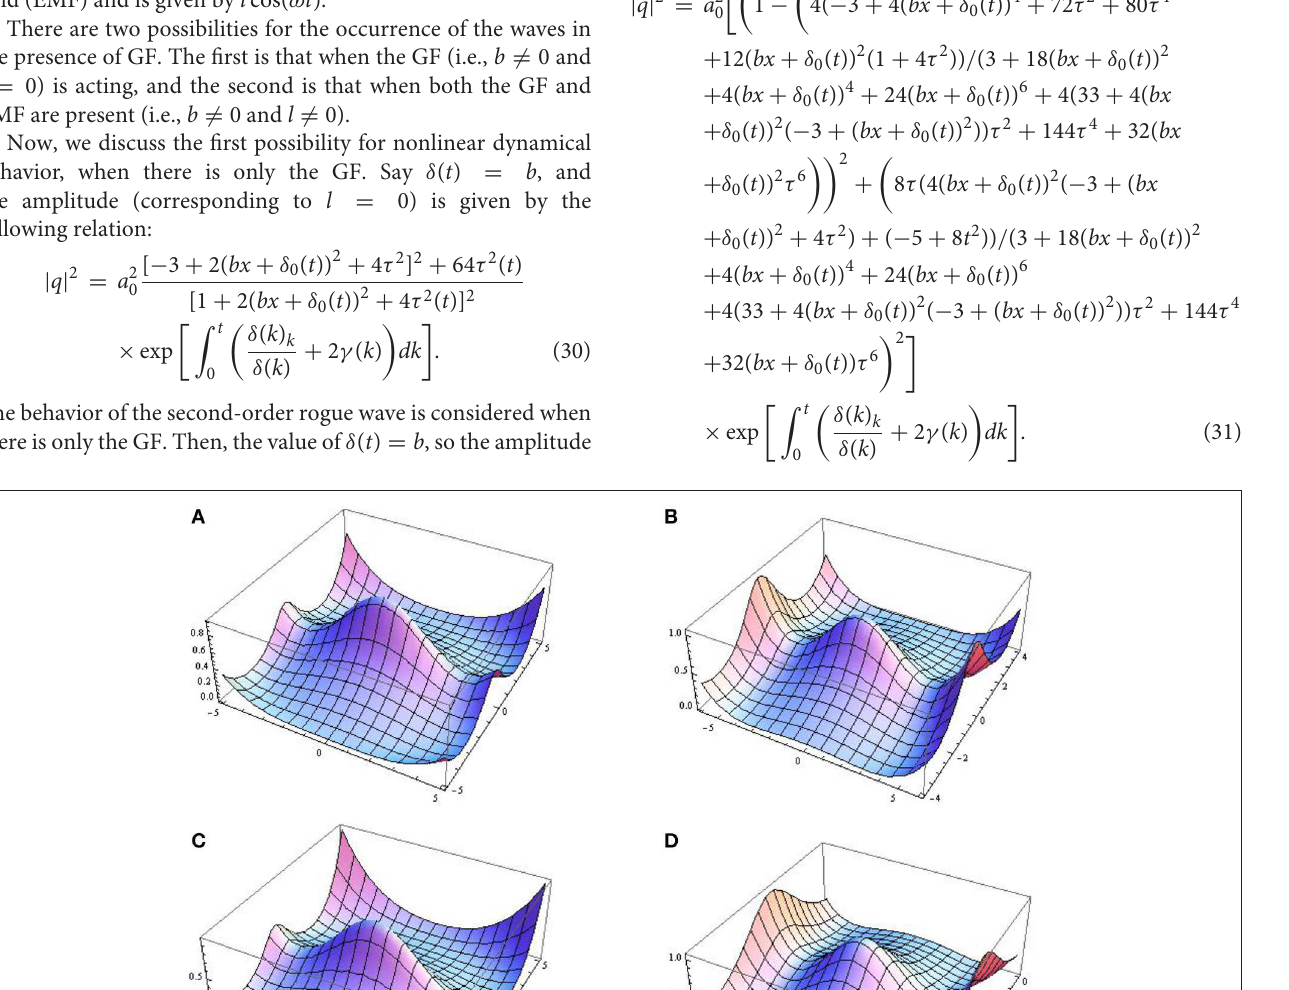
0.1, (B) δ ( t ) 0.4 and δ 0 ( t ) = = 0.5 1.2cos(0.005 t ) and δ 0 ( t ) = +